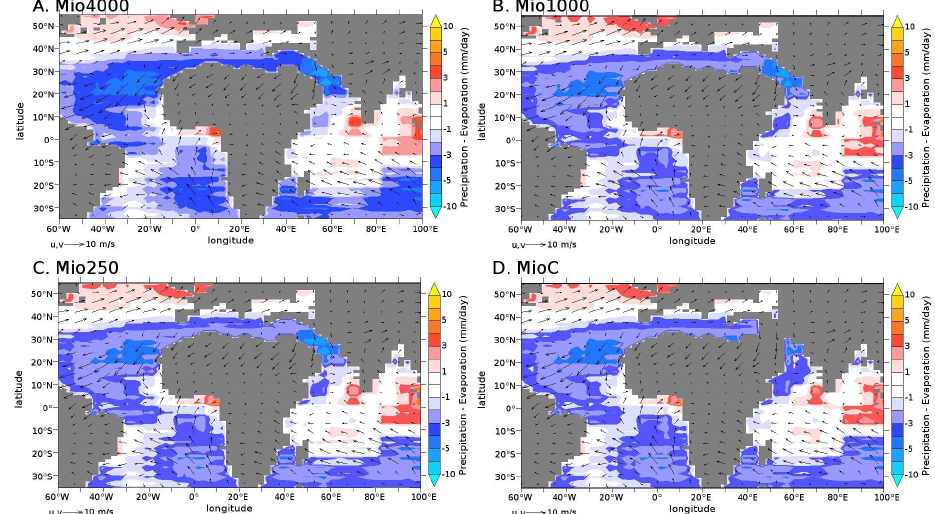
Fig. 5. Simulated boreal summer precipitation minus evaporation rate (mmday − 1 ). Vectors indicate summer surface wind speed (ms − 1 ).